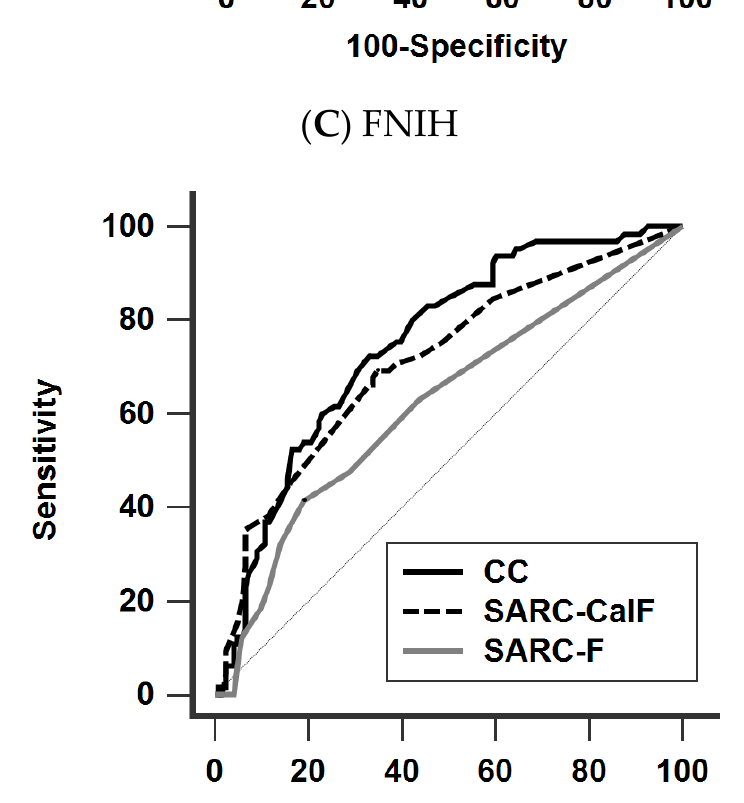
Table 4. The diagnostic performance of SARC-F, SARC-CalF, and CC on sarcopenia based on four operational definitions in the overall study population. Definitions